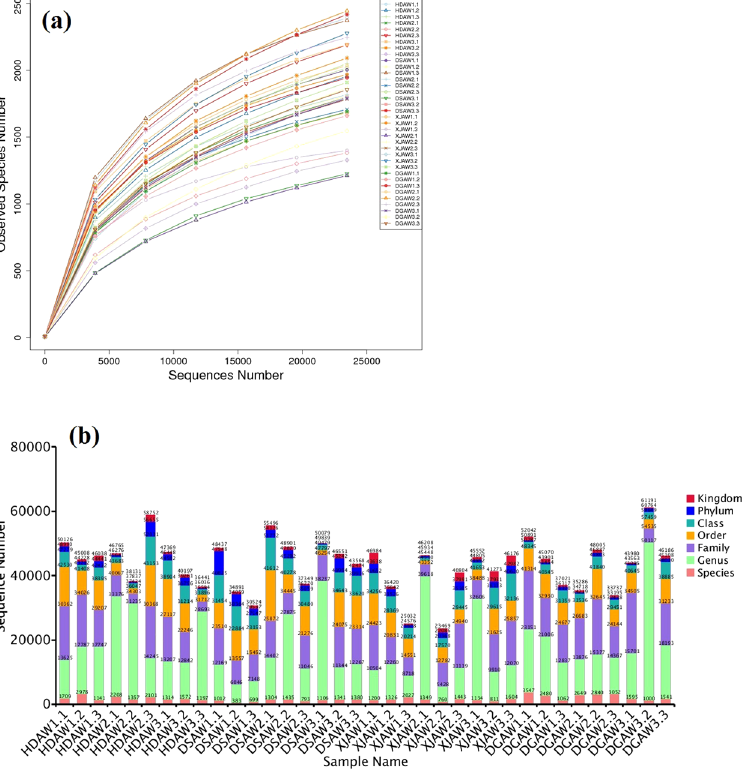
Figure 1. ( a ) Rarefaction curves of OTUs at 97% similarity for each sample and ( b ) Distribution of the number of tags on each classification level (k, p, c, o, f, g, s). Abbreviations: HDAW, F. syreitschikowii ; XJAW, F. gracilis ; DSAW, F. ferulaeoides; and DGAW, F. lehmannii . The first number indicates the root depth (1, 2, and 3 represent the 3, 20, and 40 cm depths, respectively) and the second number represents the replicate